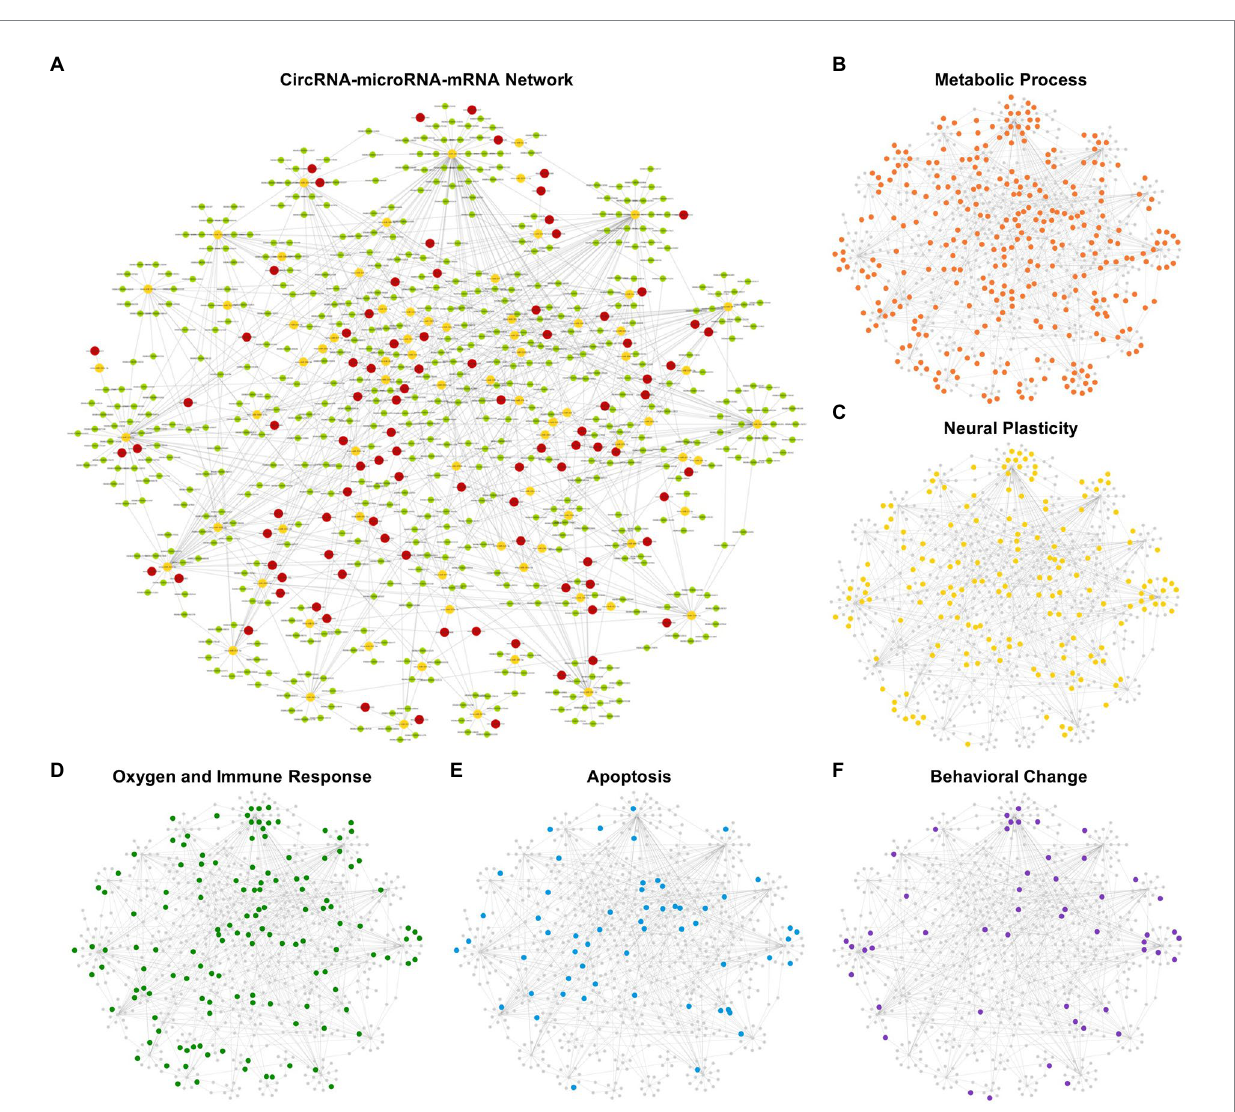
FIGURE 7 competing endogenous RNA (ceRNA) network of DEcircRNA–DEmiRNA–DEmRNA. 92 DEcircRNAs were obtained to have binding sites on 76 DEmiRNAs with 549 target DEmRNAs. Circles in red represent DEcircRNAs, circles in yellow represent DEmiRNAs and circles in green represent DEmRNAs (A) . The mRNAs classified according to the GO analysis were highlighted in the ceRNA network, respectively, as metabolic process, apoptosis, oxygen and immune response, neural plasticity, and behavior related Terms (B–F)